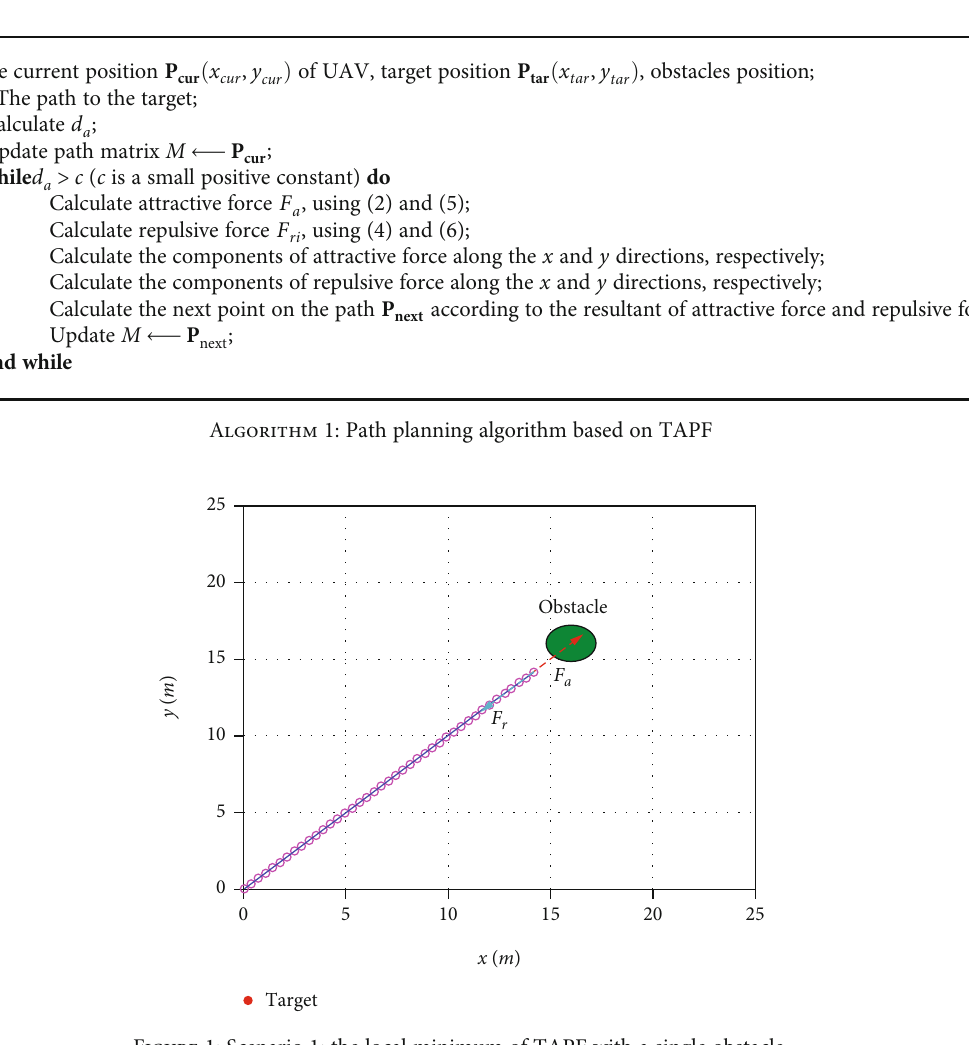
Figure 1: Scenario 1: the local minimum of TAPF with a single obstacle.